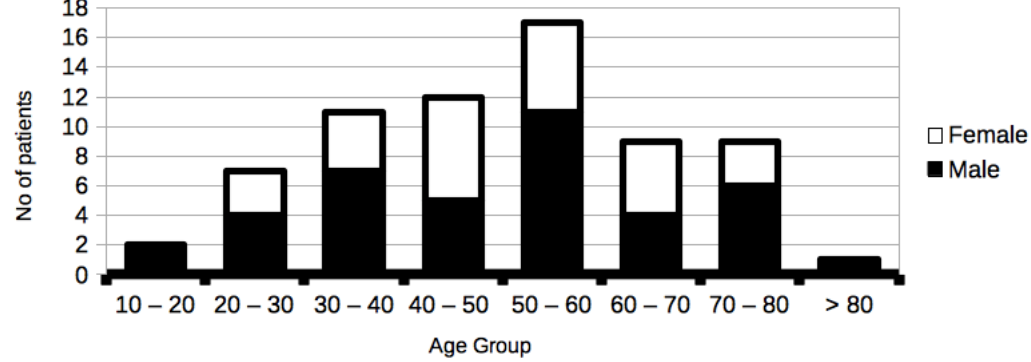
Figure 1: Age and sex-wise distribution of respondents.